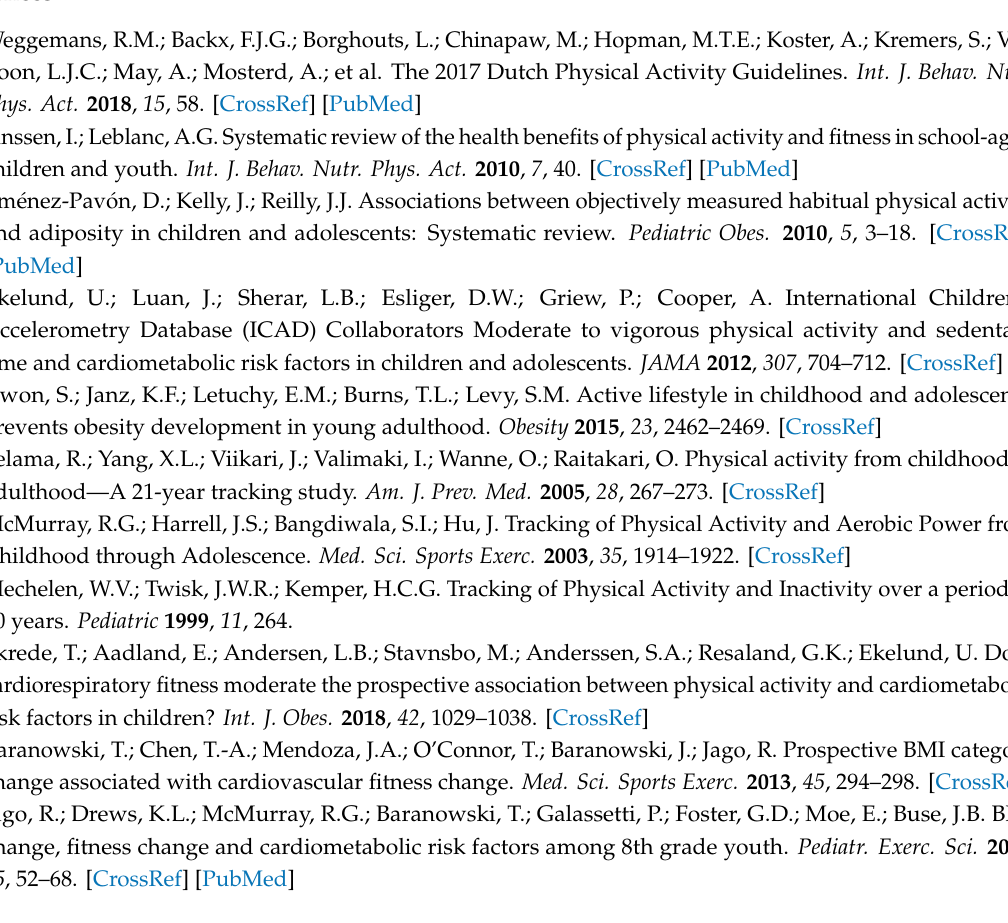
Table S1: Timing of Variable Measures across the Three Timepoints, Table S2: Comparison of PA Patterns across Subsets of the Total Sample at Age 13 Years; Table S3: Relation between PA Pattern Score and Age in Boys and Girls; Table S4: Variation in PA Pattern Score across the Di ff erent Models in Boys and Girls; Table S5: Cross-Sectional and Longitudinal Associations between CRF Score and Cardiometabolic Health Outcomes in Boys; Table S6: Cross-Sectional and Longitudinal Associations between BMI and Cardiometabolic Health Outcomes in Boys; Table S7: Cross-Sectional and Longitudinal Associations between CRF Score and Cardiometabolic Health Outcomes in Girls; Table S8: Cross-Sectional and Longitudinal Associations between BMI and Cardiometabolic Health Outcomes in Girls; Table S9: Cross-Sectional Associations between PA Pattern Score and Cardiometabolic Health Outcomes in Boys, Malaysia; Table S10: Cross-Sectional Associations between PA Pattern Score and Cardiometabolic Health Outcomes in Girls, Malaysia; Figure S1: Average Trajectory of Adolescents’ PA from 13 to 17 Years (N = 1718); Figure S2: Flow Chart of Sample Size Recruited and Used for